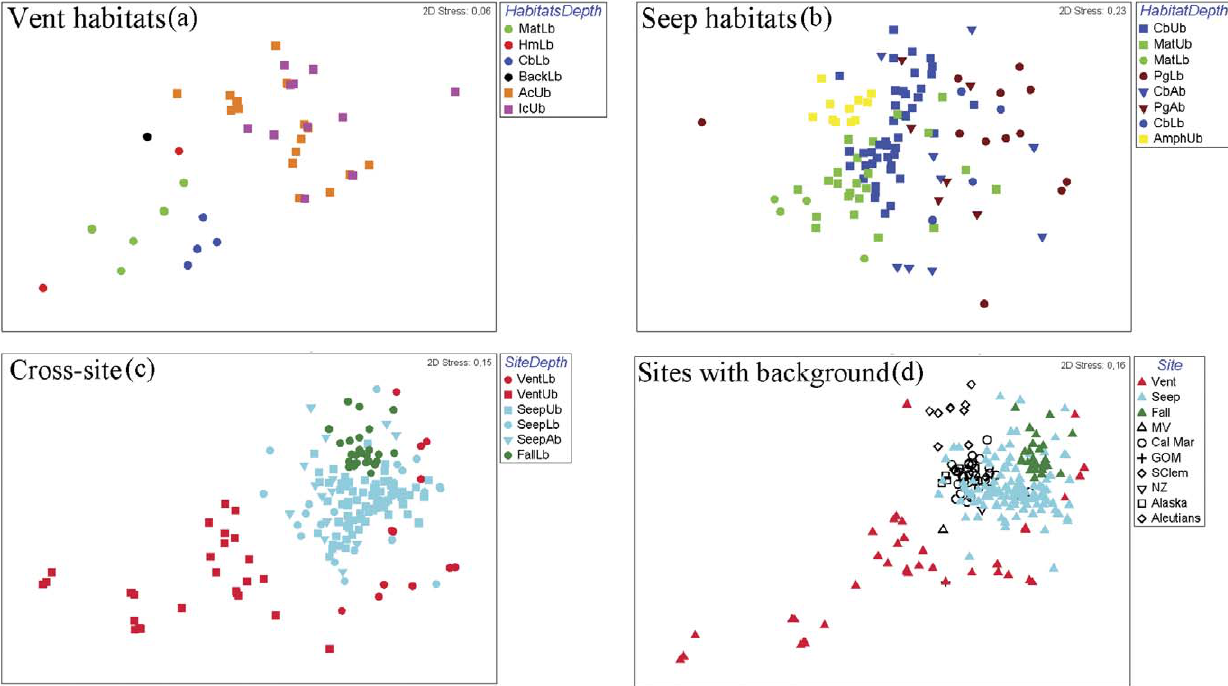
Figure 4. MDS plots of family-level abundance based on the Bray Curtis similarity index. Panels A–C: Squares – Upper bathyal (Ub 200– 1500 m); Circles – Lower bathyal (Lb 1501–3000 m); Triangles - Abyssal (Ab . 3000 m) samples. Colors indicate habitats within sites: Light green - microbial mats (Mat), Dark blue - clam beds (Cb), Red - hot muds (Hm), Orange - active venting (Ac), Pink - inactive venting (Ic), Brown - frenulate beds (Pg), Yellow - ampharetid beds (Amph); Black - Background sediments. Panel D: Symbols indicate background samples (in black) in different basins (sites).